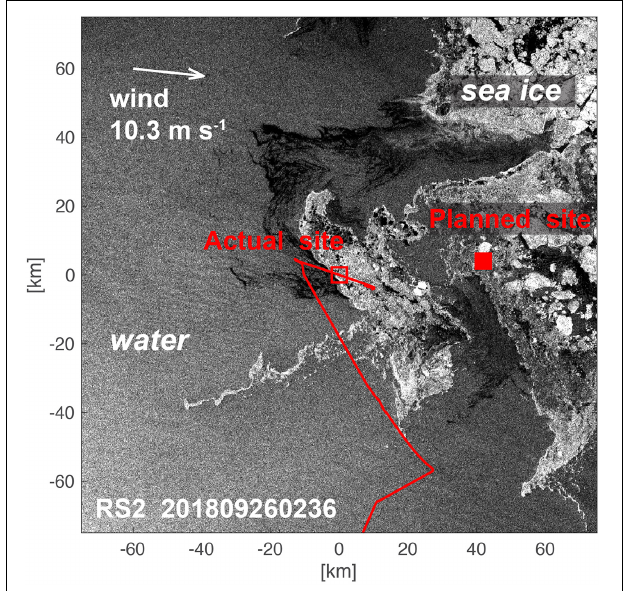
FIGURE 7 | RS2 image from 2018-09-26 02:36, 24 h before the start of the mooring deployment. Red line is the track of Healy during the 24-h period after the image acquisition, as the mooring deployment site was adjusted from the planned (solid red square) to actual (open red square) location. In general, gray areas represent open water (left of image), white areas are sea ice (right of image), and the dark areas are newly forming sea